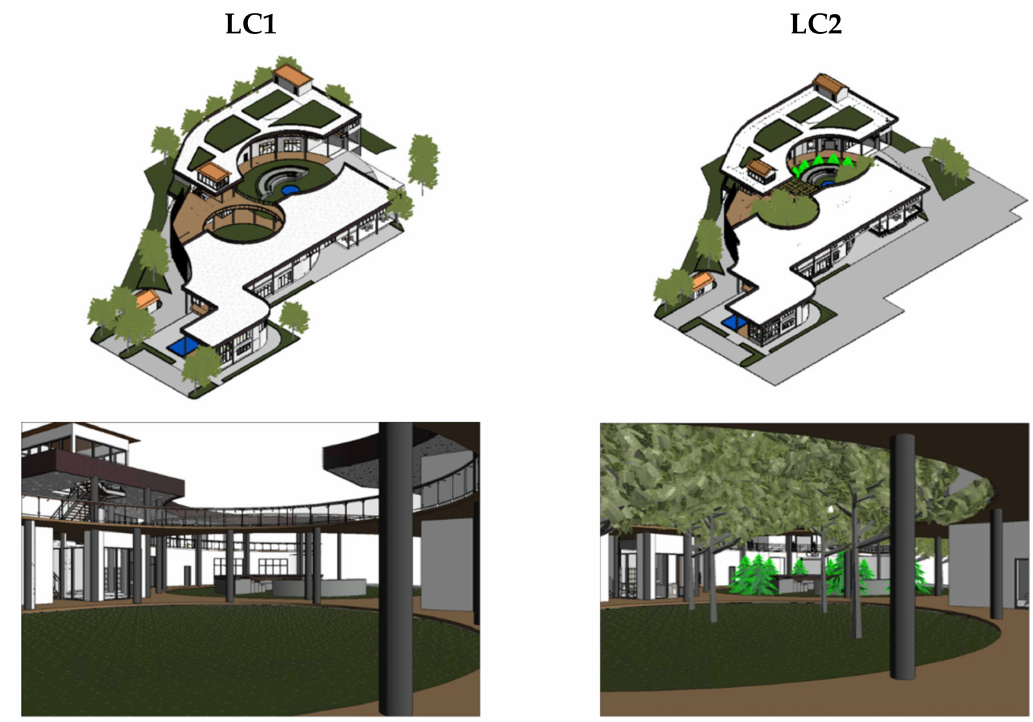
Figure 5. Design options of LC projects (LC1 and LC2).